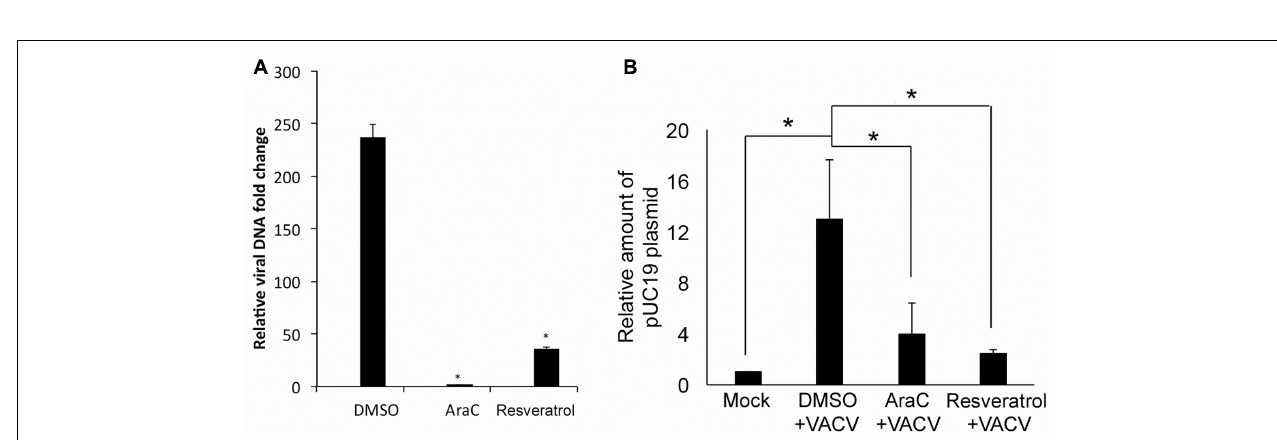
FIGURE 6 | Resveratrol suppresses VACV DNA synthesis. (A) HeLa cells were infected with VACV at an MOI of 1 in the presence of DMSO, AraC (40 µ g/mL), or resveratrol (50 µ M). Relative viral DNA levels in infected cells were determined by real-time PCR at 1 and 24 hpi. The viral DNA level at 24 hpi was determined as the fold to the viral DNA level at 1 hpi. (B) HeLa cells were transfected with 200 ng of pUC19 plasmid and incubated overnight. The cells were then infected with VACV at an MOI of 5 or mock-infected in the presence of AraC, resveratrol, or DMSO. Total DNA was extracted from the cells at 24 hpi and 1 µ g of total DNA was digested with DpnI at 37 ◦ C for 2 h followed by real-time qPCR using primers amplifying pUC19 fragment containing DpnI digestion site. The asterisk indicates significant difference ( P < 0.05) and the ns indicates no significant difference between 1 and 24 hpi. The error bar indicates standard deviation.